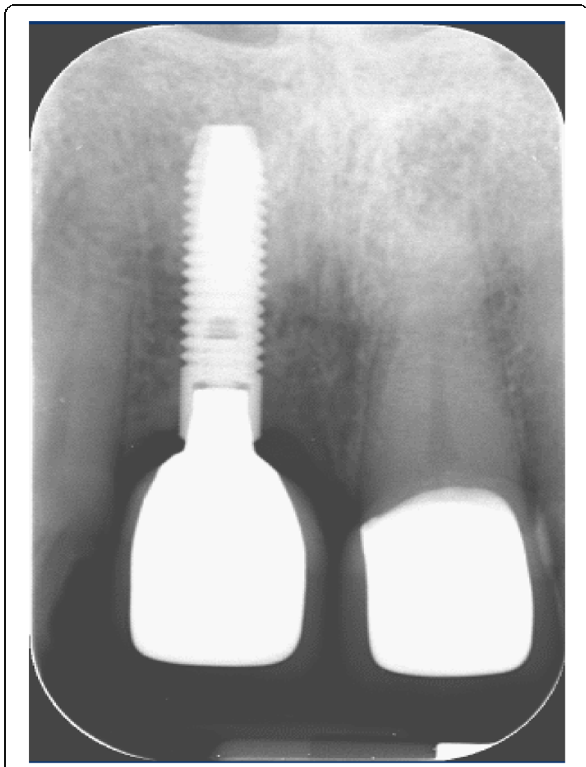
Fig. 16 Single tooth X-ray, 1year post-implantation, showing the finalized crown